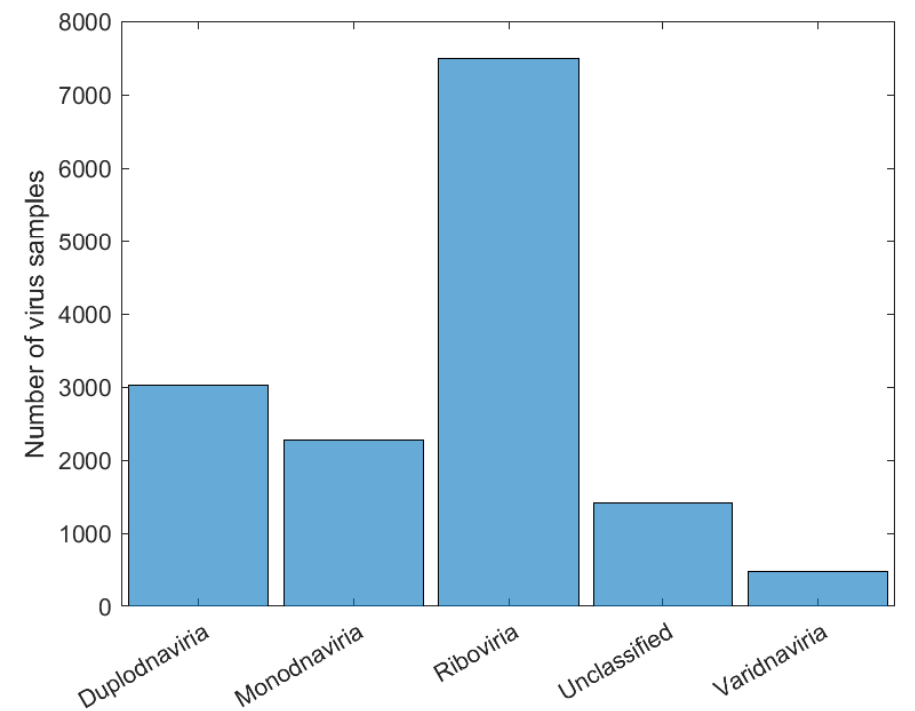
Figure 4. Number of samples in each realm and with unclassified label before